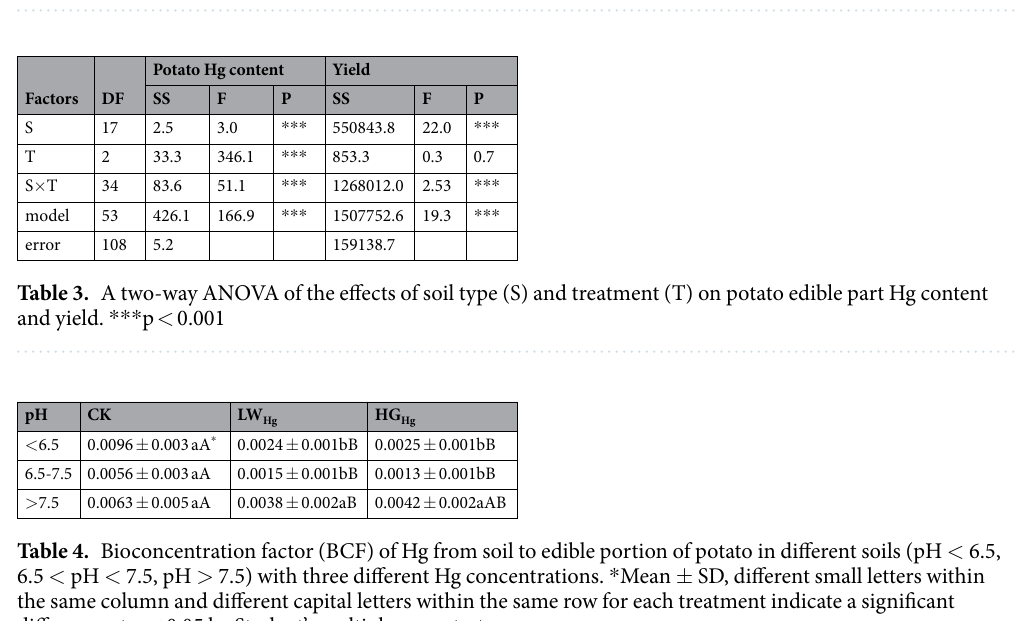
Figure 2. Bioconcentration factor (BCF) of Hg from soil to edible portion of potatoes in each Hg